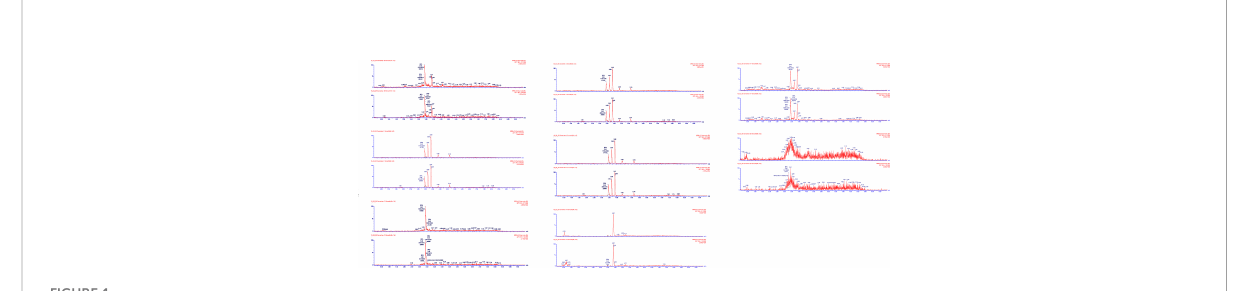
FIGURE 1 Chromatograms of the saliva samples and BPA reference standard. Saliva samples analyzed and con fi rmed by